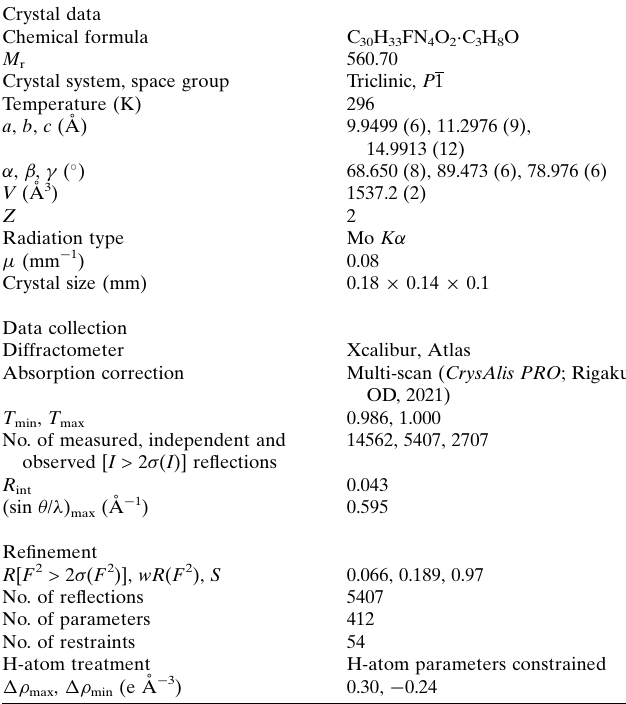
Crystal data Chemical